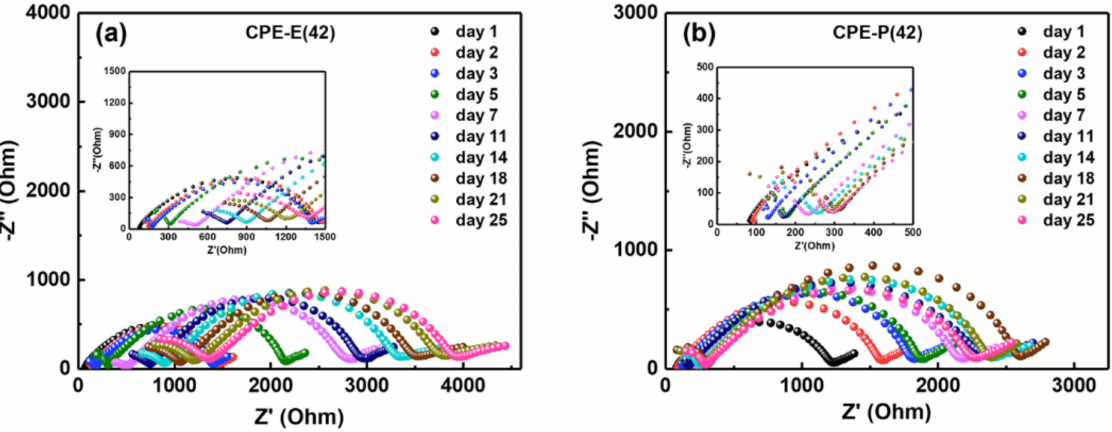
Figure 7. Nyquist plots of Li|CPE-E(42)|Li ( a ) and Li|CPE-P(42)|Li ( b ) cells over time at room